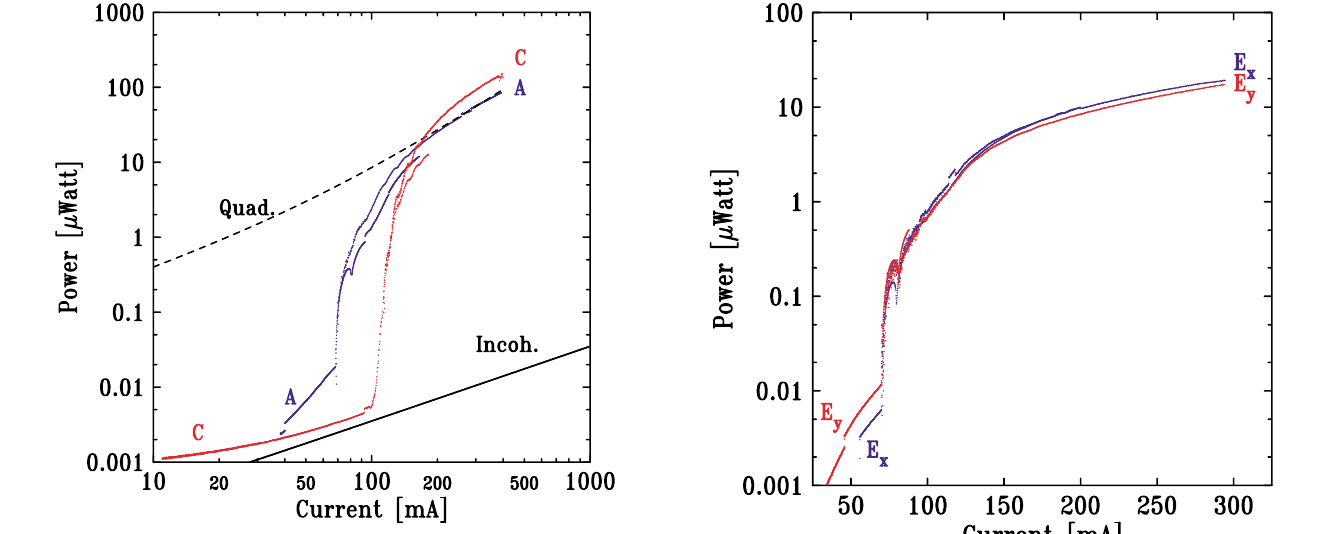
FIG. 5. (Color) The average power in A peak versus current for the two directions of linear E -field polarization of the collected